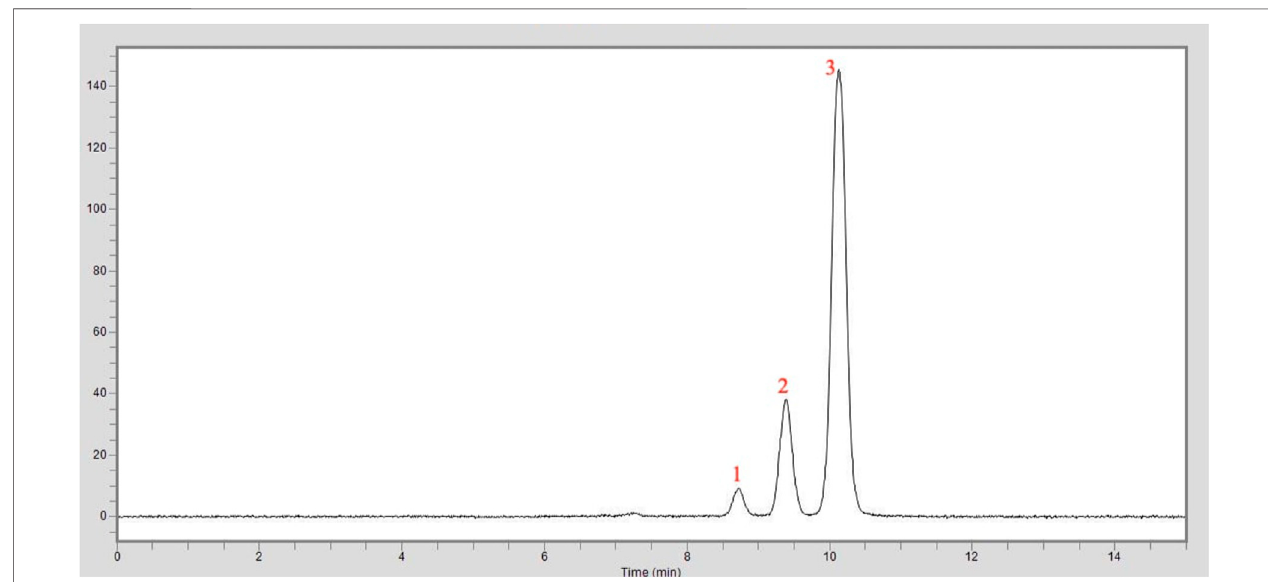
FIGURE 4 | HPLC chromatogram of the curcumin analysis in the turmeric extract: 1. Peak: Bisdemethoxycurcumin, 2. Peak: Demethoxycurcumin, 3. Peak: Curcumin.